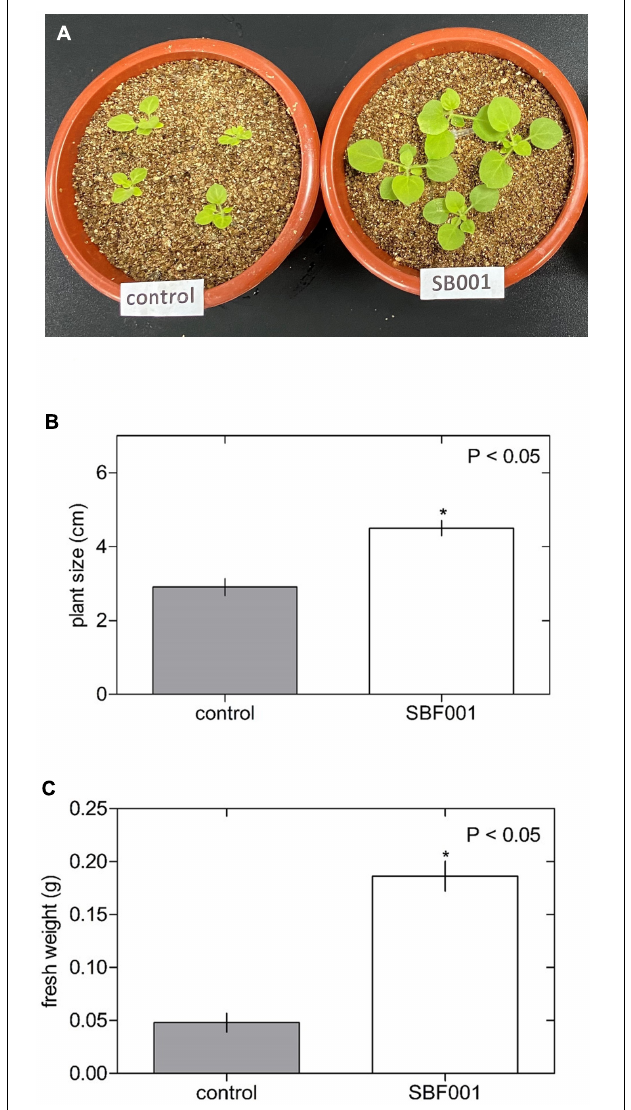
FIGURE 3 | Endophytic bacterium B. altitudinis induces significant Nicotiana tabacum plant growth. Plants (5-day-old) were mock-treated (control) or inoculated with 30 ml of B. altitudinis at 4.77 × 10 9 CFU/ml. (A) Phenotype of N. tabacum plants mock-treated (control) and treated with B. altitudinis fermentations (SB001) at 20 days post-inoculation. Effect on plant size (B) and fresh weight (C) of N. tabacum plants mock-treated (control) and treated with B. altitudinis fermentations (SB001). Each bar represents mean values with standard errors of two independent experiments ( n = 10). * P ≤ 0.05.